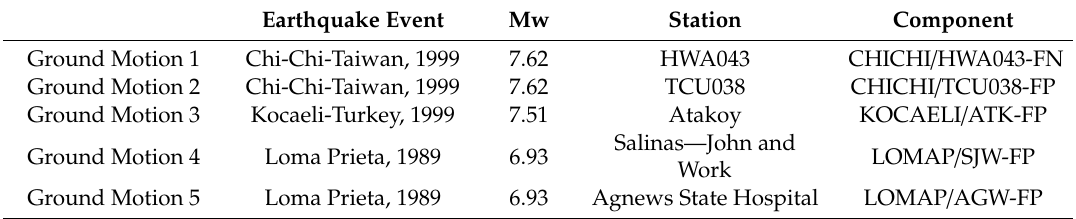
Table 1. Five natural ground motions used in the time-history